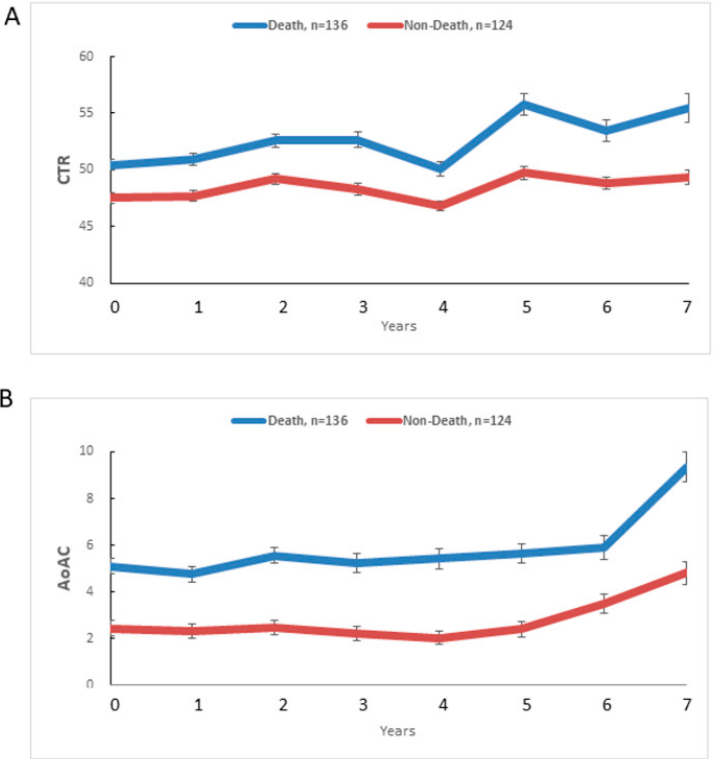
Figure 2. Mean CTR ( A ) and AoAC ( B ) at each follow-up year for death (blue, n = 136) and non-death (red, n = 124) patients. Table 5. Time course of mean change in CTR or AoAC from baseline (0 year) to 7 years in the death and non-death groups.